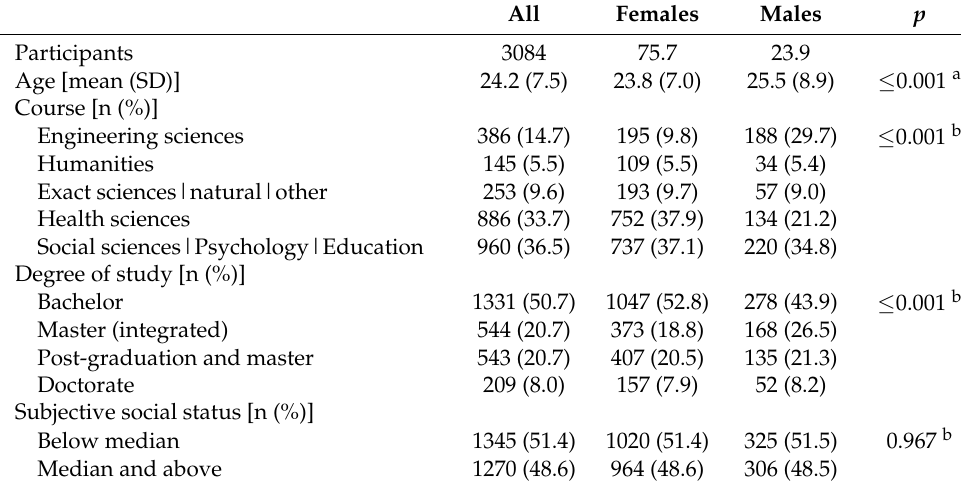
Table 1. Descriptions of participants.